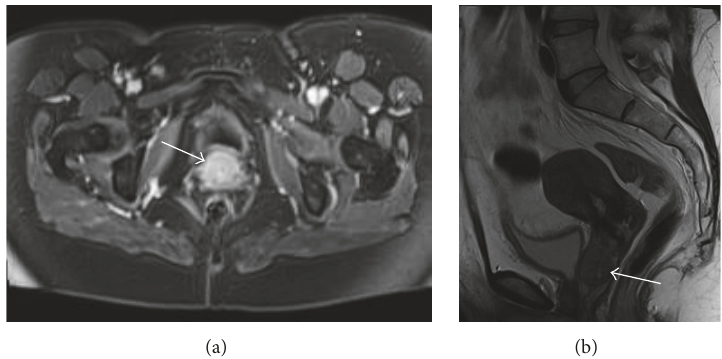
Figure 1: CT scan of the pelvis with (a) and without contrast (b) shows lesion on the anterior wall of the vagina, adjacent to the bladder (denoted by white arrow).